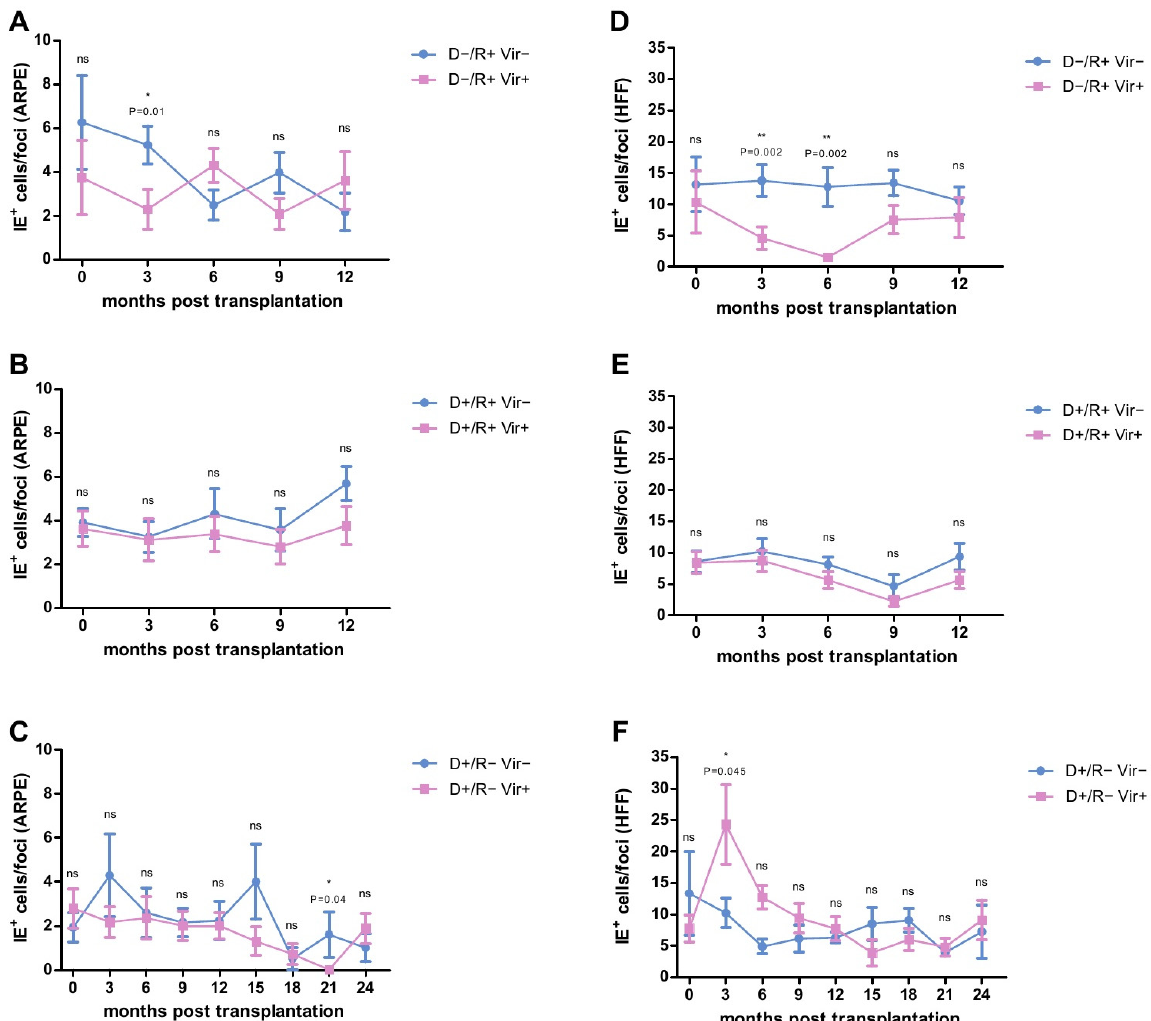
Figure 2. Analysis of the Focus Expansion Assay (FEA) on epithelial cells (ARPE) ( A – C ) and fibroblasts (HFFs) ( D – F ) with plasma obtained from D − /R+ ( A , D ), D+/R+ ( B , E ) and D+/R − ( C , F ) lung transplant recipients (LTRs) after lung transplantation (LTX). D − /R+ and D+/R+ LTRs were tested at 0, 3, 6, 9 and 12 months post LTX. D+/R − LTRs were tested at 0, 3, 6, 9, 12, 15, 18, 21 and 24 months post LTX. Data are shown as mean values ( ± SEM). Plaque sizes at each time point were compared between viremic (>1000 copies/mL) (pink) and non/low-viremic (<1000 copies/mL) (blue) LTRs by Mann-Whitney Test; p < 0.05 was considered significant. * p < 0.05; **, p < 0.01. IE + : HCMV-immediate early positive cells.